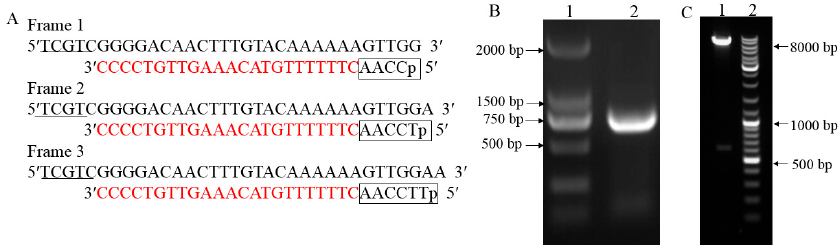
Figure 1. The three reading frames pGADT7 attB vector reconstruction and bait vector construction. ( A ): Reconstruction of pGADT7 attB vector for the generation of three reading frames. pGADT7 vector was reconstructed to represent the three possible reading frames by inserting one (T) or two nucleotides (TT) behind the attB1 sequence with AACC which is boxed. The 5 (cid:48) end contains protective bases that are underlined. ( B ): Gel electrophoresis image of aureochrome (AUREO) amplification from cDNA. Lane 1 is DNA marker whose strip size is writen on the left, lane 2 is the PCR product of AUREO from cDNA. ( C ): Gel electrophoresis image of the recombinant plasmid AUREO-pGBKT7 which was